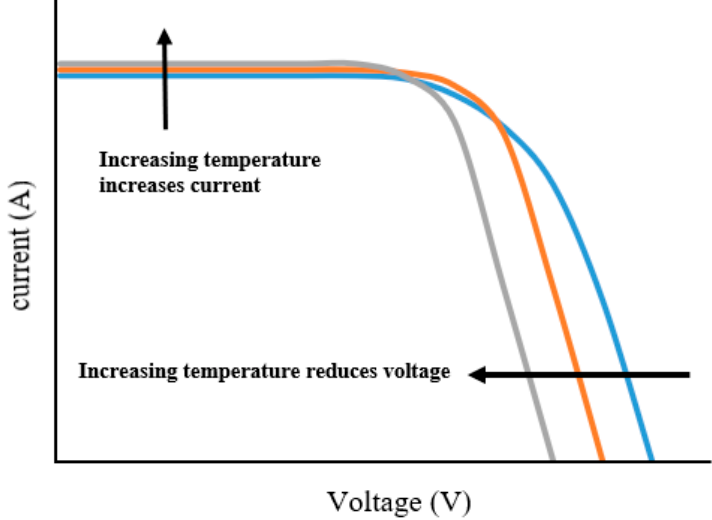
Figure 1. Effect of temperature on the I–V characteristic.